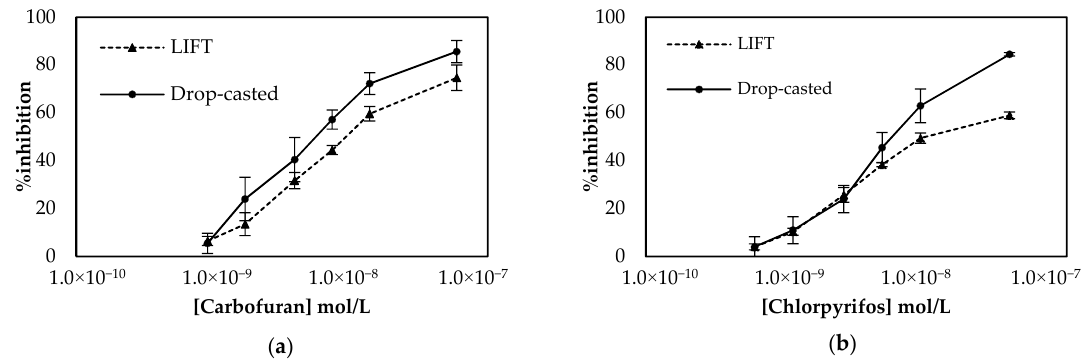
obtained using sensors functionalized with fCB/CS/AChE following the one-step approach. The Figure 7. Comparison of the calibration curves for ( a ) carbofuran and ( b ) chlorpyrifos in bu ff er obtained